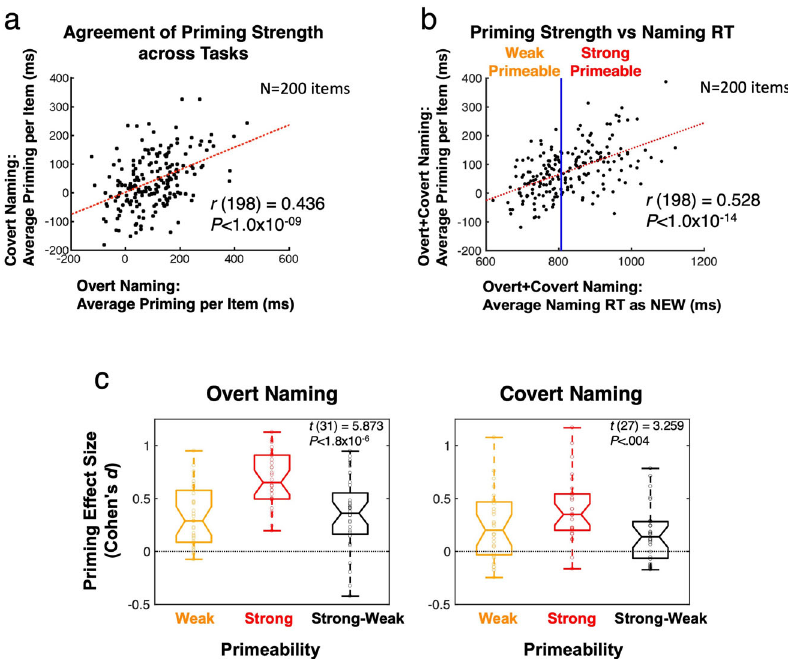
Fig. 4 Repetition priming and Primeability. a When averaged across participants within each task, priming magnitudes speci fi c to each of the 200 stimuli are highly reliable across task. For the Covert Naming task, these priming magnitudes were assessed in a post-fMRI session during which participants overtly named all stimuli (either pre-exposed as OLD or novel to the fMRI session as NEW). b When responses are averaged across both participants and tasks, a strong relationship was observed between average response time (RT) to an object when NEW and the subsequent priming magnitude observed. Items were subjected to a median split based on the RT when NEW (using the group-average normative data) to classify objects as either Strong Primeable (slow RT) or Weak Primeable (fast RT), permitting a within-participant measure of “ Primeability ” . Statistics in ( a ) and ( b ) are based on N = 200 independent stimuli. c When grouping objects by Primeability (either Strong or Weak), priming effect sizes for each participant were indeed greater for Strong compared to Weak Primeable objects in the Overt Naming task (left panel); this is expected since these responses contributed to the original calculation of Primeability. However, this same relationship was also found for the Covert Naming button-press response times during fMRI, which were not used in calculating Primeability (right panel). The middle horizontal line in each box plot represents the median (50th %ile), the horizontal lines just above and below the median represent the 25th and 75th %iles, the top and bottom horizontal lines represent the minimum and maximum values, and the boundaries of the horizontal notches inside the 25th and 75th %iles depict the 95% con fi dence limits of the median. Individual datapoints are plotted as open circles. Statistics in ( c ) are based on N = 32 independent participant datasets for Overt Naming and N = 28 independent datasets for Covert Naming. For related content in SI, see Supplementary Fig.